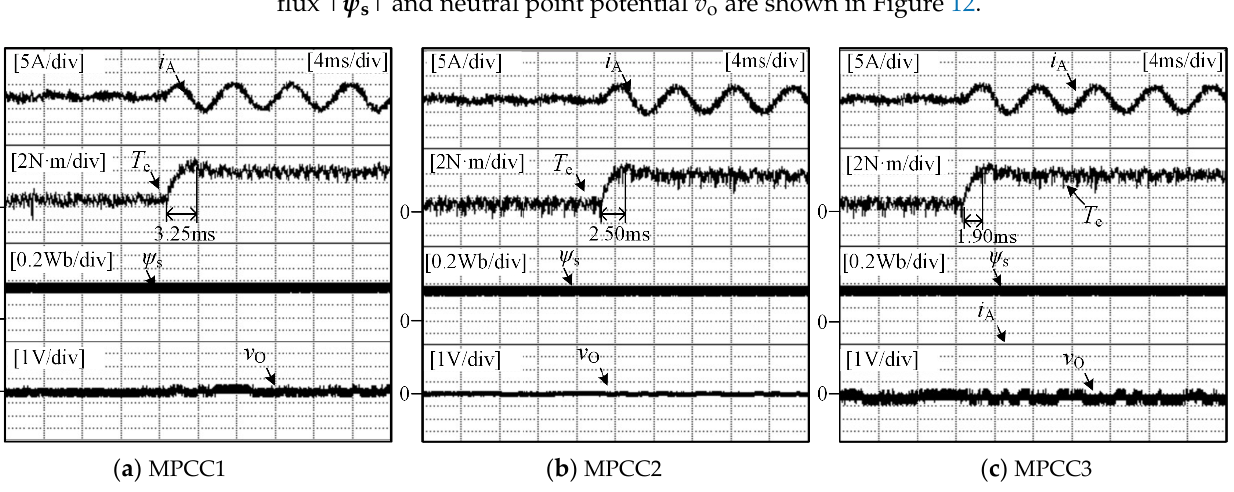
Figure 11. Performance evaluation indicators for case 1 and case 2. From Figure 11, under large neutral point potential conditions, the D T , D ψ and I THD of MPCC3 are all lower than those of MPCC1 and MPCC2, which verifies that the steady state performance of the improved MPCC is superior to that of conventional MPCC.